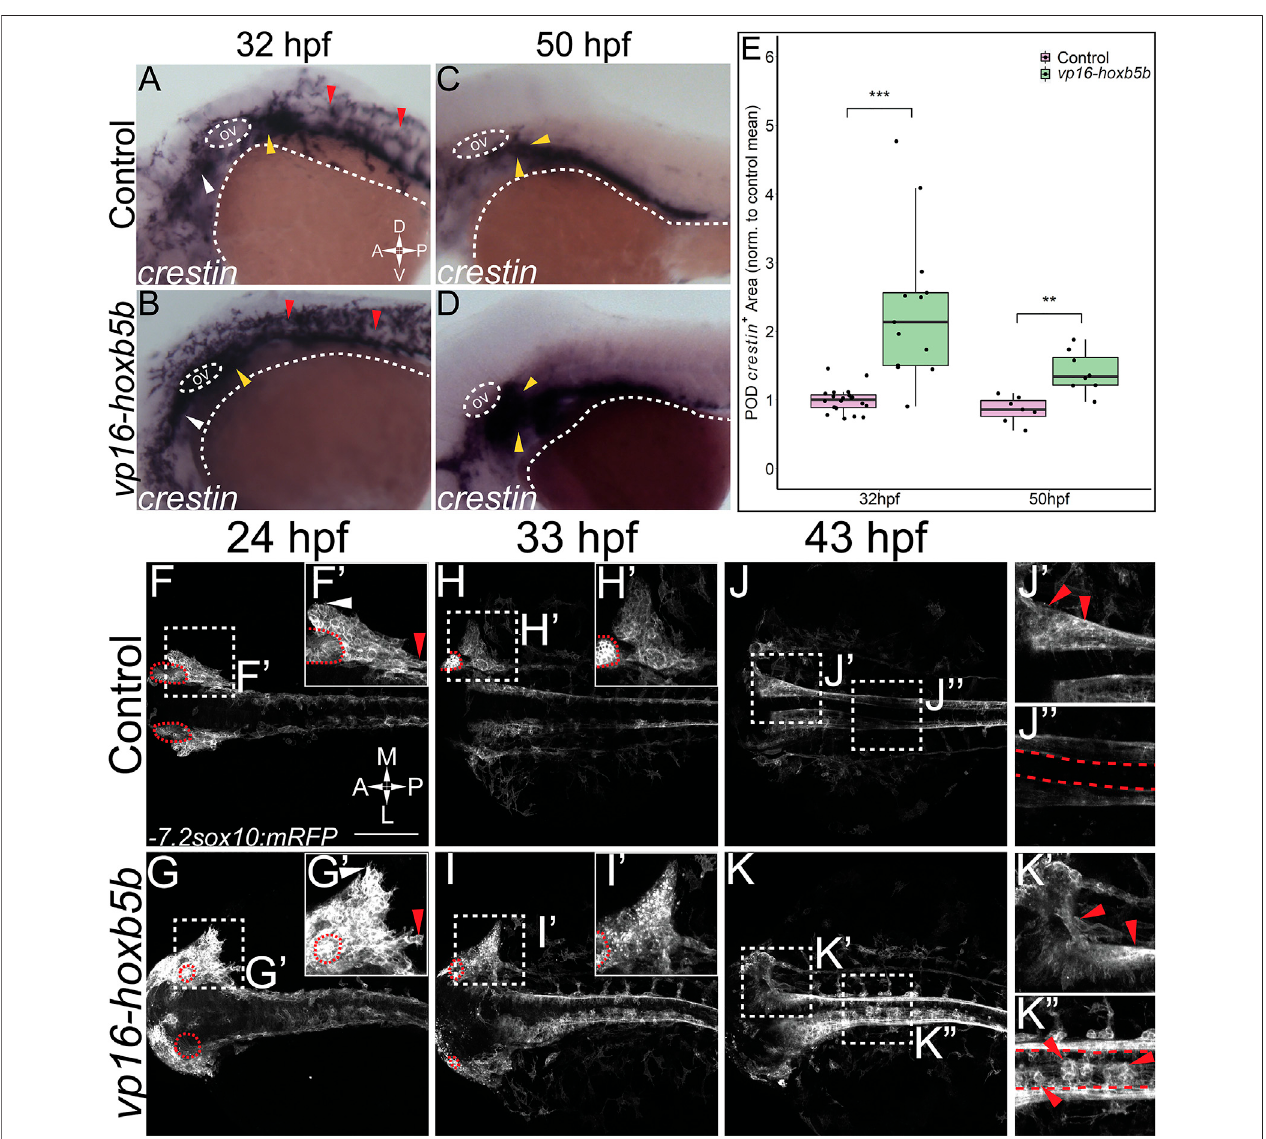
FIGURE2 | Elevated Hoxb5b activity globallyincreasesboth number and localization ofneural crestcells. (A – D) in situ hybridization for NCC using a crestin probe at both 32 hpf (A,B) and 50 hpf (C,D) . crestin + domains for embryos injected with 15 pg of vp16-hoxb5b mRNA (B,D) were expanded in the post-otic (yellow arrowheads), cranial (white arrowheads), and spinal cord (red arrowheads), compared to uninjected embryos (A,C) . (E) Quanti fi cation of expanded vagal crestin + domains shows signi fi cant expansion at both 32 hpf (control n (cid:1) 27; vp16-hox5b n (cid:1) 21; p (cid:1) 3.03 × 10 – 5 ) and at 50 hpf (control n (cid:1) 7; vp16-hox5b n (cid:1) 8; p (cid:1) 0.00114). (F – K) Maximum intensity projection stills taken from confocal time lapse movies of sox10:mRFP embryos. Controls ( n (cid:1) 2) were compared to 30 pg vp16- hoxb5b injectedembryos( n (cid:1) 4),examinedfrom24 hpfto43 hpfandseriallyimagedalongthedorsalaspectofthevagaldomain.mRFP + NCCsaregrosslyexpandedin the vagal domain ( G,G ’ arrowheads) over controls ( F,F ’ , arrowheads). This expansion persists through the course of development, resulting in ectopically localized cells along the dorsal aspect of the embryo ( K ” ) and in the post-otic pool ( K ’ ). Scale Bars in (F) : 100 μ M. Anterior: